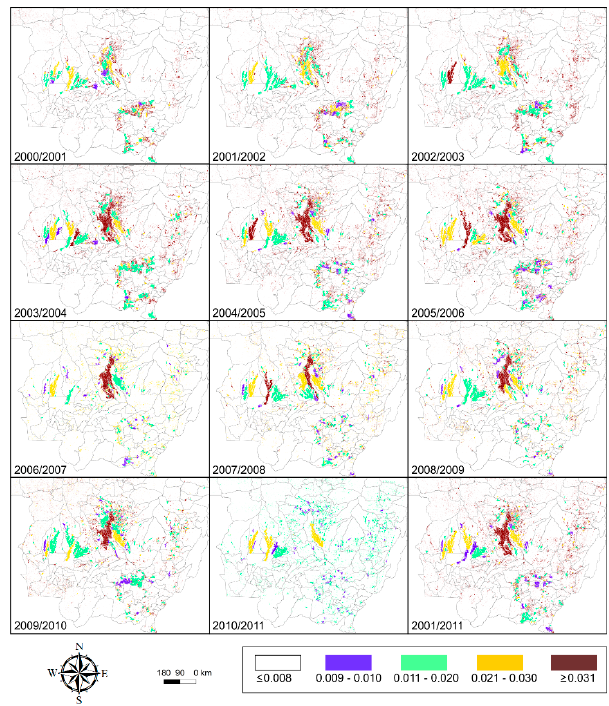
Figure 8. Binomial areal kriging prediction standard error of the percentage of occurrence of soybean crop areas inside soybean harvested areas detected by remote sensing, per harvest period (2000/2001 to 2010/2011) and the averaged years (2001/2011).